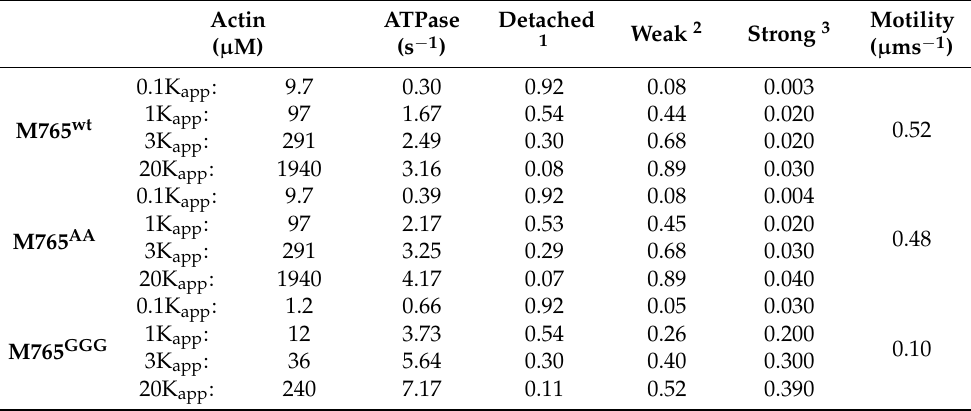
Table 6. Fractional occupancies of actin-attached and actin-detached states of